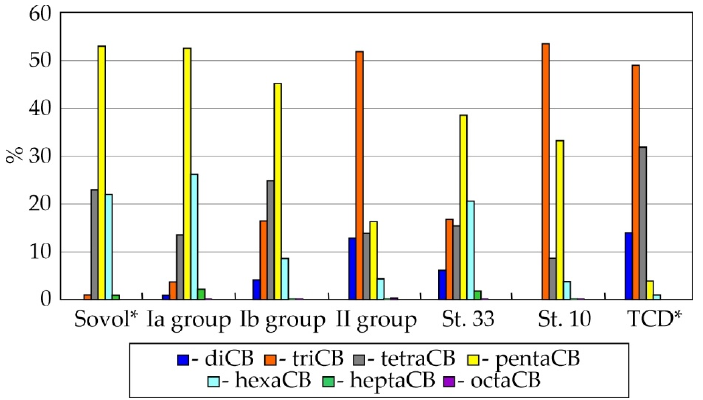
Figure 5. The PCB homological patterns (%) in groups obtained by the cluster method in comparison to homological patterns in technical mixtures of PCB (Sovol and trichlorodiphenyl (TCD); * [61]). The dominant low chlorinated (for example, PCB-28 in the Himalayas [7]) and higher chlorinated (for example, PCB-101 and PCB-138 in mountains in Slovakia [42]) PCB con- geners in the total PCB have also been found in snow in other regions of the world. The prevalence of higher chlorinated PCB congeners is likely due to the snow aging when high